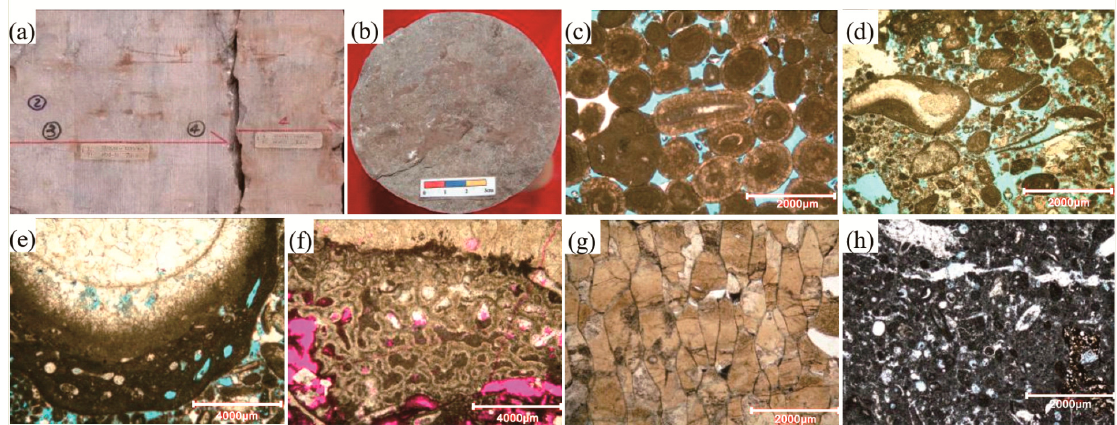
Figure 6. Paleontologic characteristics and various carbonate rock types of Callovian-Oxfordian Stage. ( a ) Grey white gypsum rock, 2247.45–2247.92 m, XVac, Well NFar-21, platform interior evaporitic; ( b ) Micrite, 2377.06–2377.29 m, XVp, Well Sam53-1, restricted platform; ( c ) Ooidal grainstone, 2372.69 m,